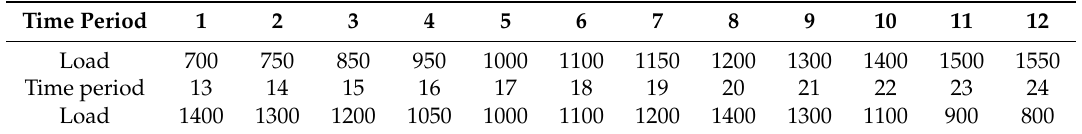
Table A3. The day-ahead predicted load data (MW).